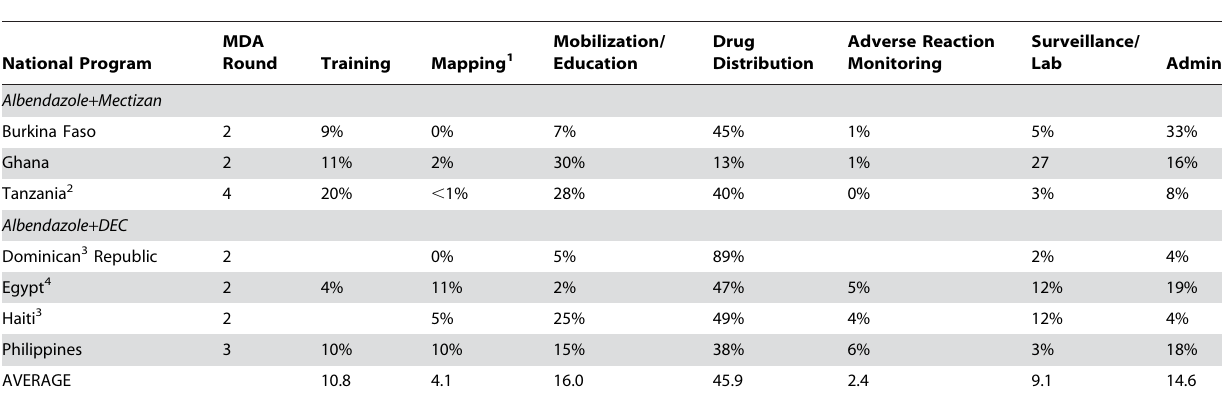
MDA Round Training Mapping 1